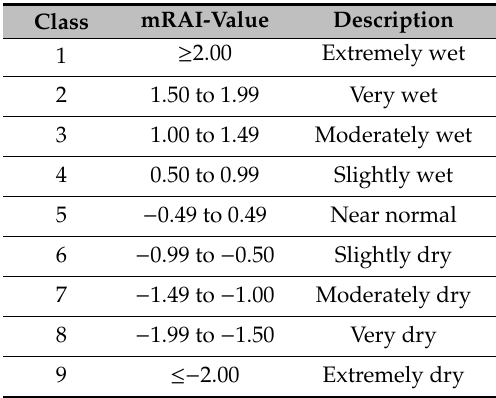
Table 1. Classification of the Modified Rainfall Anomaly Index (mRAI) into moisture classes.